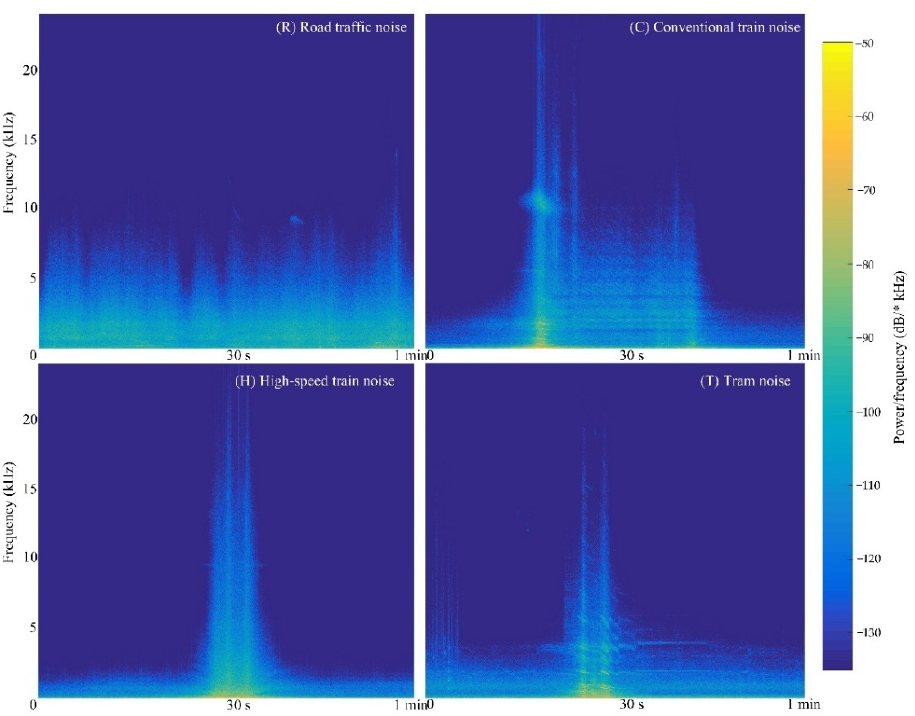
Figure 2. Spectrogram of the experiment stimuli, including road traffic sound (R), conventional train sound (C), high-speed train sound (H), and tram sound (T).